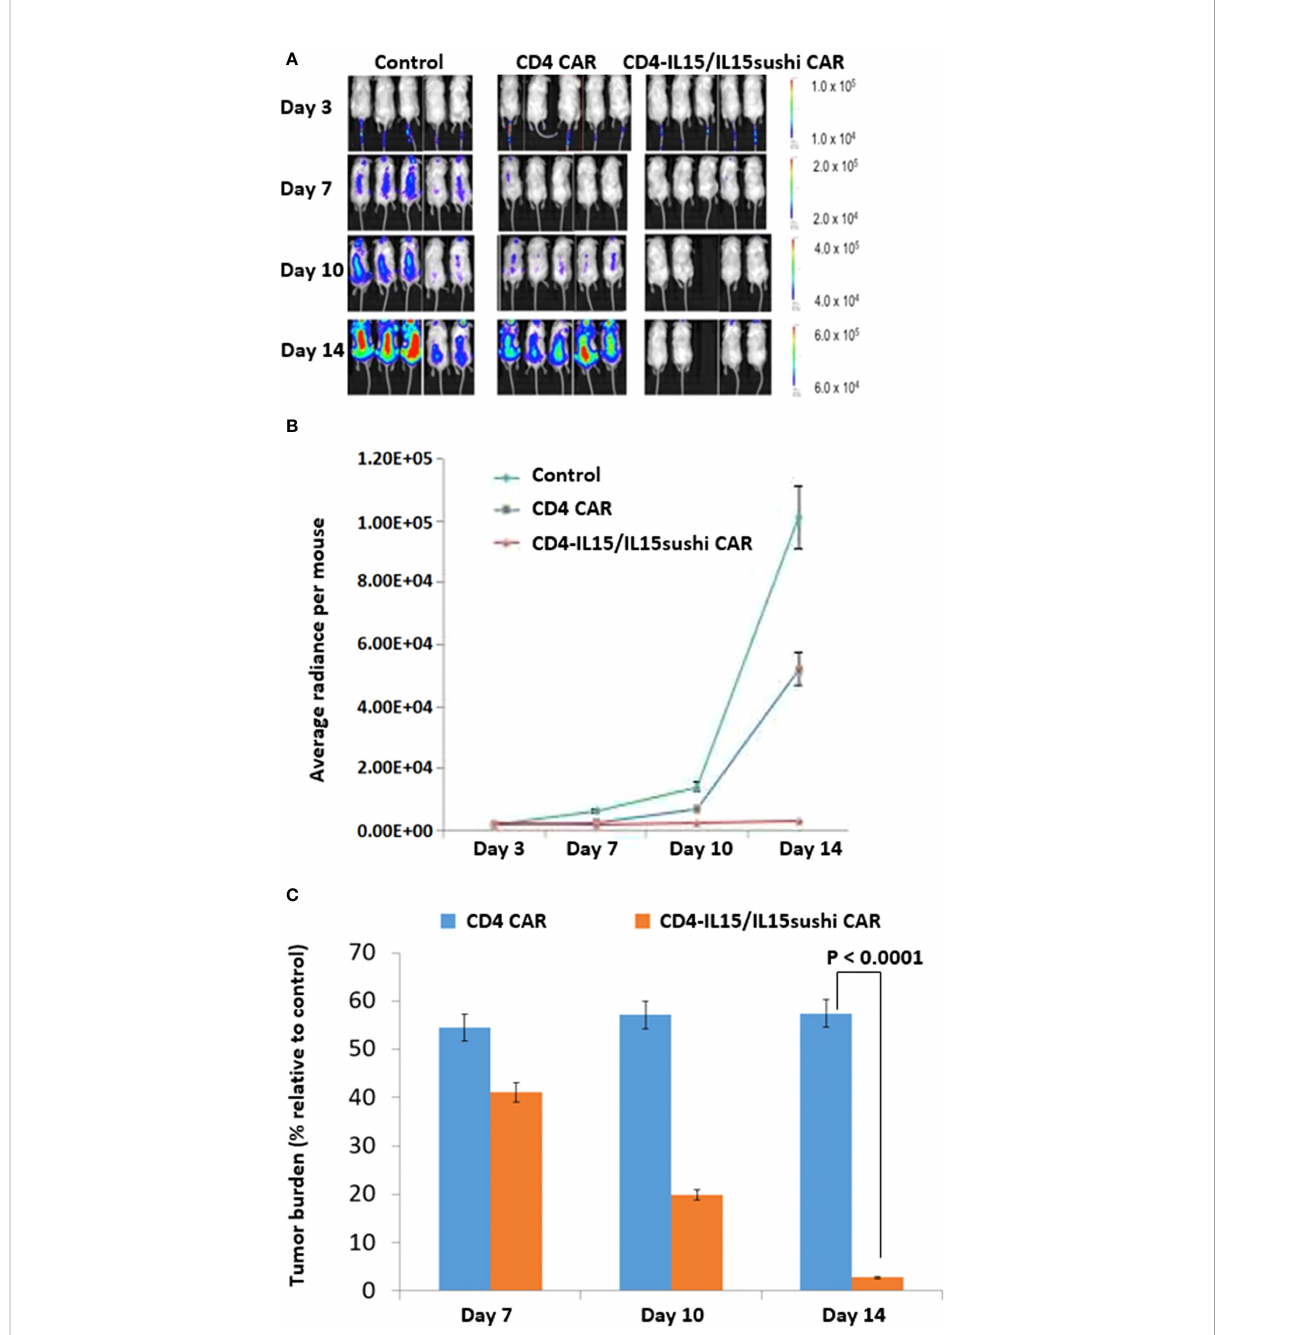
FIGURE 3 CD4-IL15/IL15sushi CAR NK92 cells reduce tumor burden in Jurkat mouse model. (A) NSG mice were sub-lethally irradiated and intravenously injected with 1.0x10 6 luciferase-expressing Jurkat cells to induce measurable tumor formation. Three days following tumor cell injection, 5 mice were intravenously injected with a course of 10x10 6 vector control NK92, CD4 CAR NK92, or CD4-IL15/IL15sushi CAR NK92 cells. On days 3, 7, 10, and 14, mice were injected subcutaneously with RediJect D-luciferin and subjected to IVIS imaging to measure tumor burden. One mouse died on Day 10 after NK92 injection, most likely due to injection procedure and NK92 cell aggregation. This mouse was sick immediately after injection. (B) Average light intensity for control NK92, CD4 CAR NK92, and CD4-IL15/IL15sushi CAR NK92 cells was measured in average total fl ux (photons/sec). CD4-IL15/IL15sushi CAR NK92 cells had lower light intensity than control and CD4 CAR groups. (C) Average light intensity measured for CD4 CAR and CD4-IL15/IL15sushi CAR was compared to that of control to determine the tumor burden in treated versus control mice. Although both conditions showed signi fi cant reduction in tumor burden by Day 7, relative tumor burden for CD4 CAR NK92 cells stayed the same to Day 14, while CD4-IL15/IL15sushi CAR NK92 cells continued to decrease by over 97%. Unpaired t-test analysis revealed an extremely signi fi cant difference (P < 0.0001) between the CD4 CAR NK92 and CD4-IL15/IL15sushi CAR NK92 treatment groups by Day